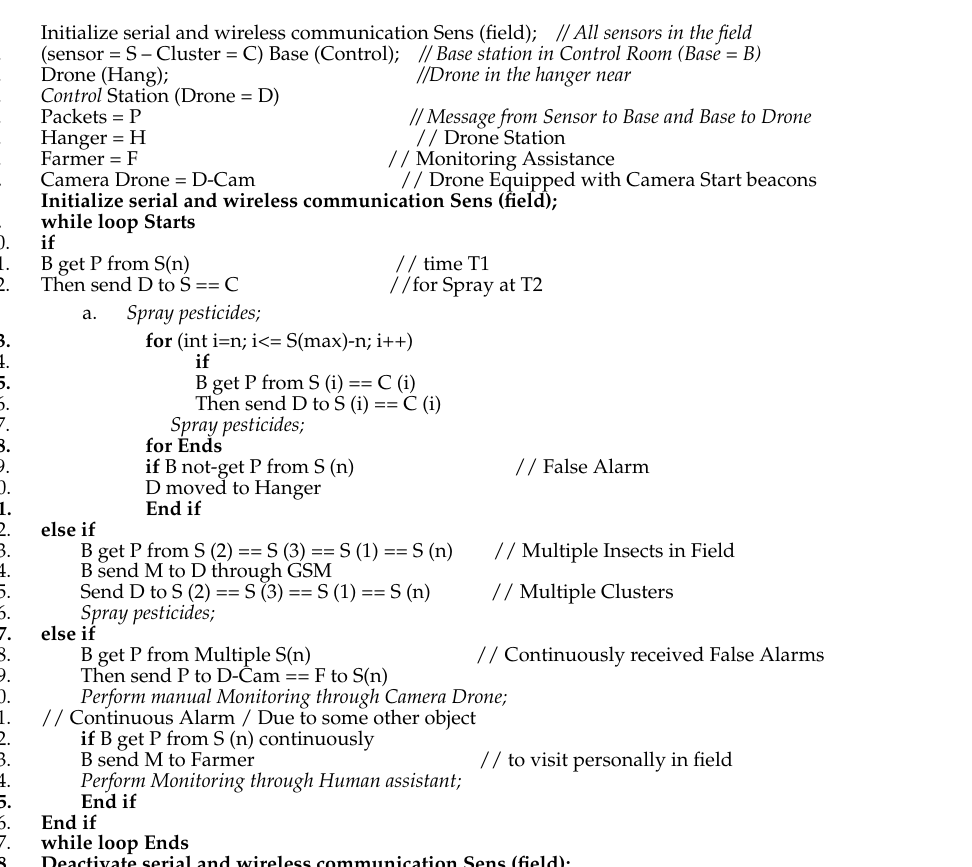
Algorithm A2: Proposed drone movement predictive